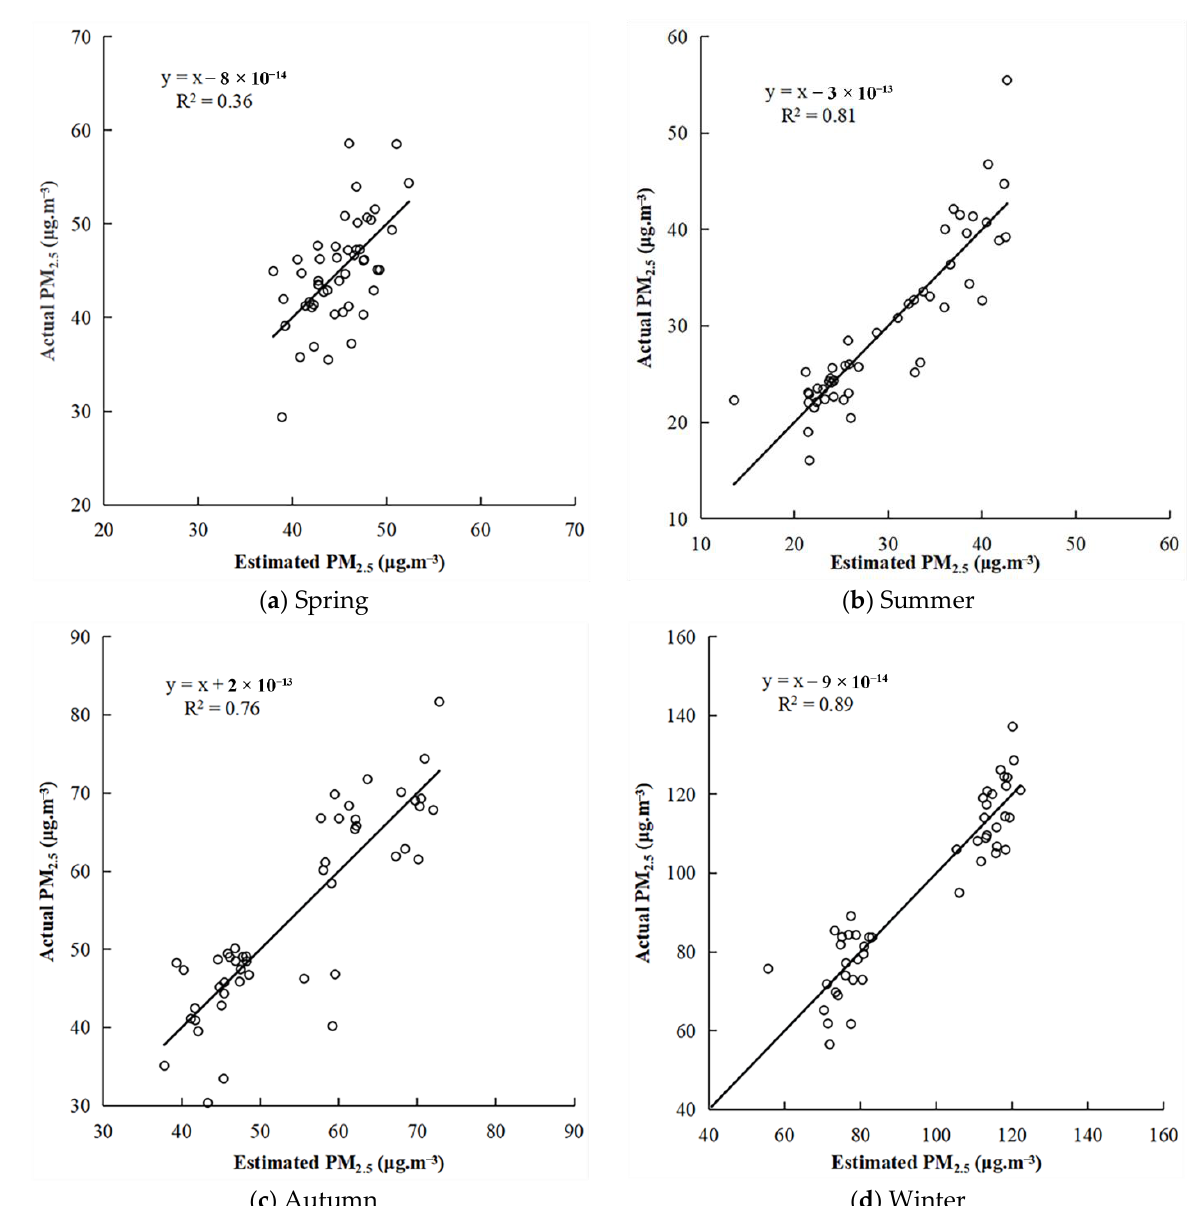
Figure 5. Scatter plots of estimated and actual PM 2.5 concentrations in the four seasons.